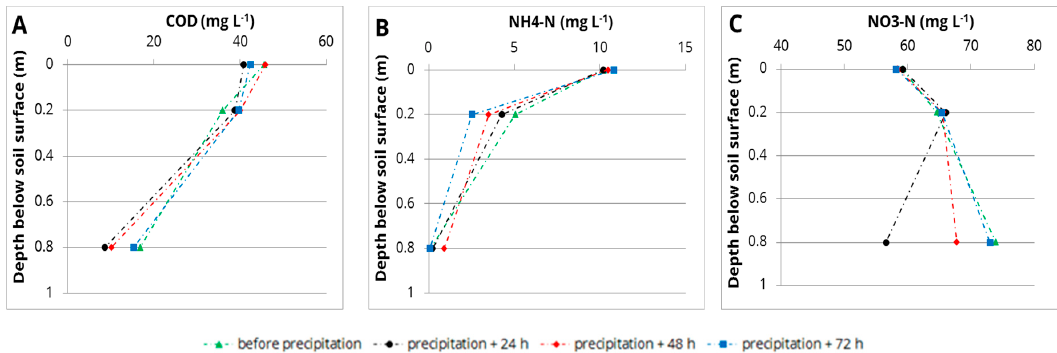
Figure 6. COD ( A ), NH4-N ( B ), and NO 3 -N ( C ) concentration profiles in the 3D-Tank (sampling points: inflow, P1 and P5) before and 24 h / 48 h / 72 h after the precipitation event of statistical recurrence interval of 5 years (WW-RE-Ref (sep.)).